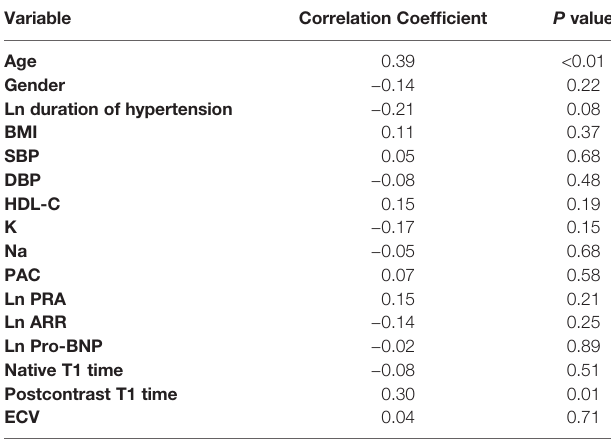
TABLE 3 | Univariable linear regression analysis for global circumferential PDSR in PA